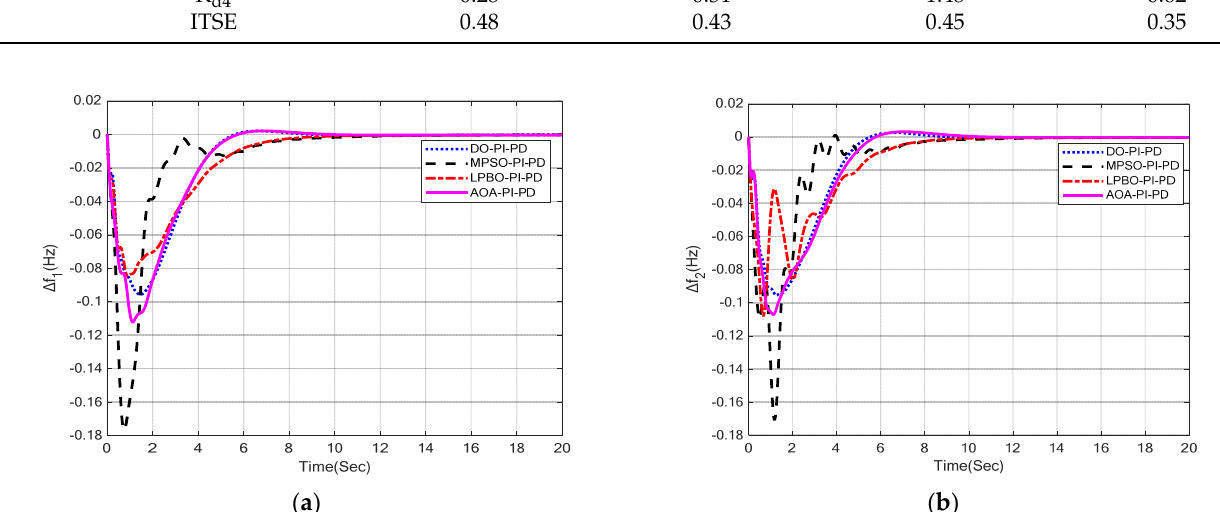
Table 9. Numerical results of LFC in a two-area multi-source realistic IPS with nonlinearities.